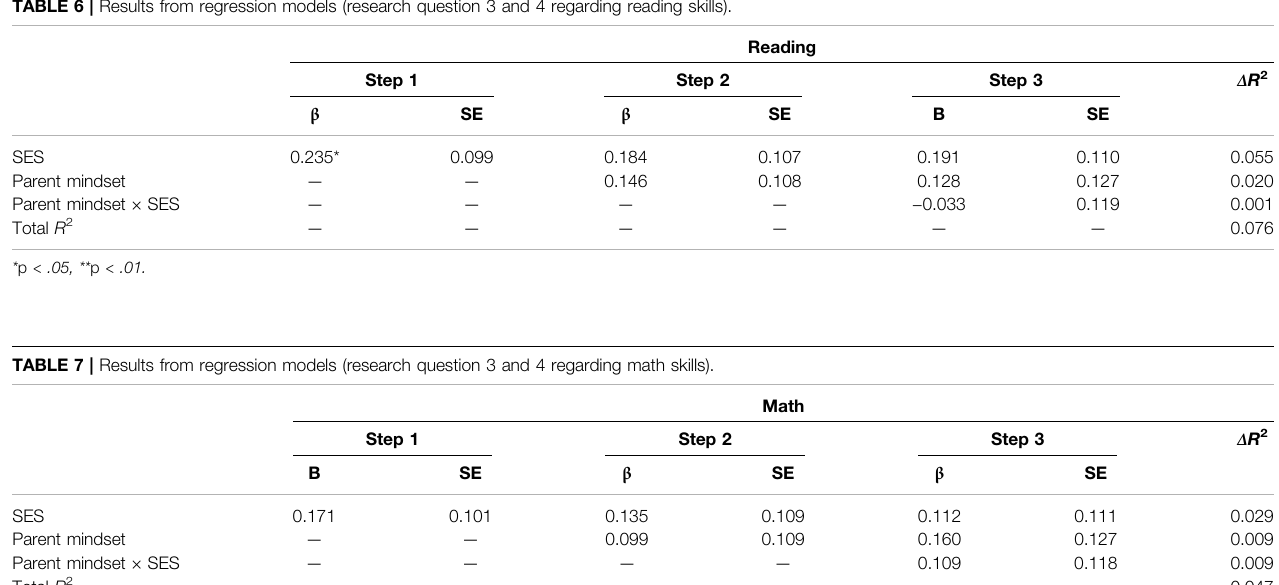
TABLE 6 | Results from regression models (research question 3 and 4 regarding reading skills).